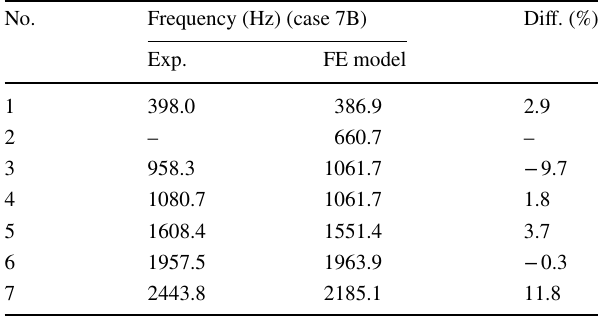
Table 5 The identified natural frequencies of the investigated rock bolt No. Frequency (Hz) (case 7B) Diff. (%)